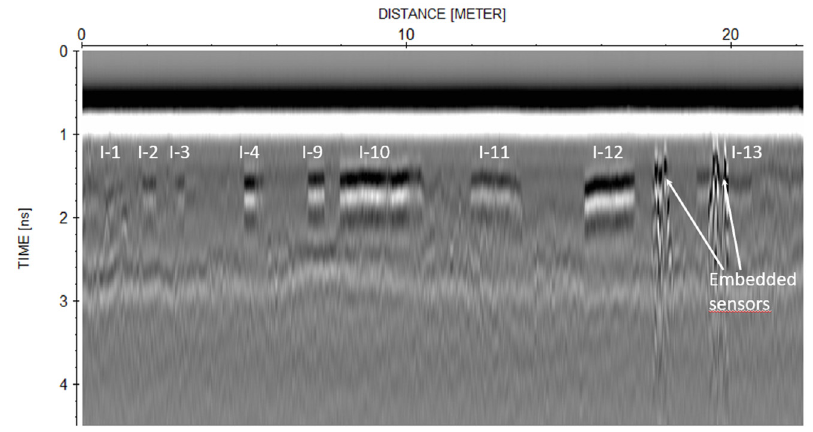
Figure 8. Example of longitudinal B-scan performed at 2.6 GHz along the complete test section. C-scans were performed at 396 K, 500 K, 600 K, 720 K, and 800 K loading stages, using